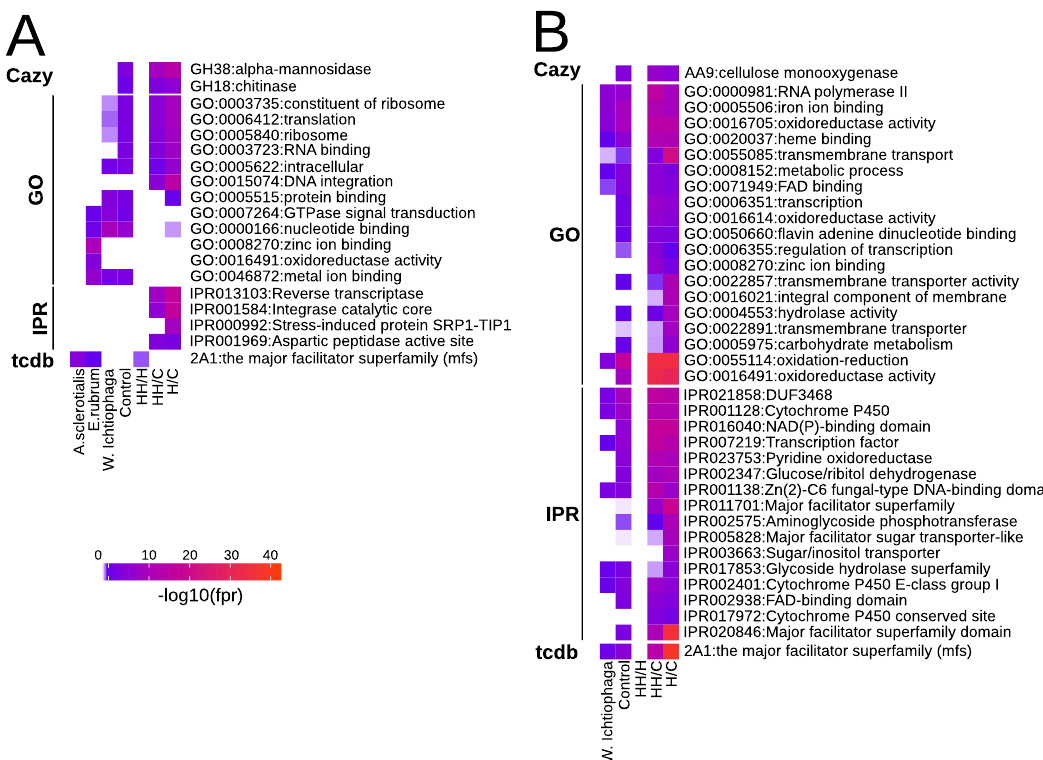
Figure 3. Heat map of the − log ( fdr ) of the significantly-enriched or -depleted functional annotations in A. salisburgensis compared to A. sclerotialis , Aspergillus ruber , and Wallemia ichthyophaga . Depletion/enrichment found in HH vs. H, HH vs. C, and H vs. C is also shown. Only entries with an enrichment/depletion with an fdr < 1e − 5 are shown. ( A ) Depletion. ( B )